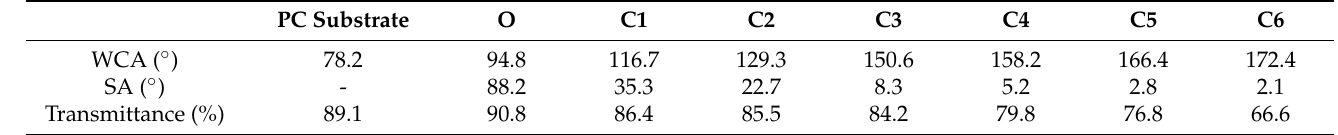
Figure 1. ( a ) WCA and SA variation of PC substrate, the coatings of O and C1~C6, here WCA is the abbreviation of Water Contact Angle and SA is the abbreviation of Slip Angle; ( b ) photograph of water droplets deposited on the coating surface of C5; ( c ) photograph of immersion state in water of the coating surface C5, ( d ) SEM image of the coating C5. Table 2. WCA, SA and transmittance values of PC substrate and the coatings of O and C1~C6.